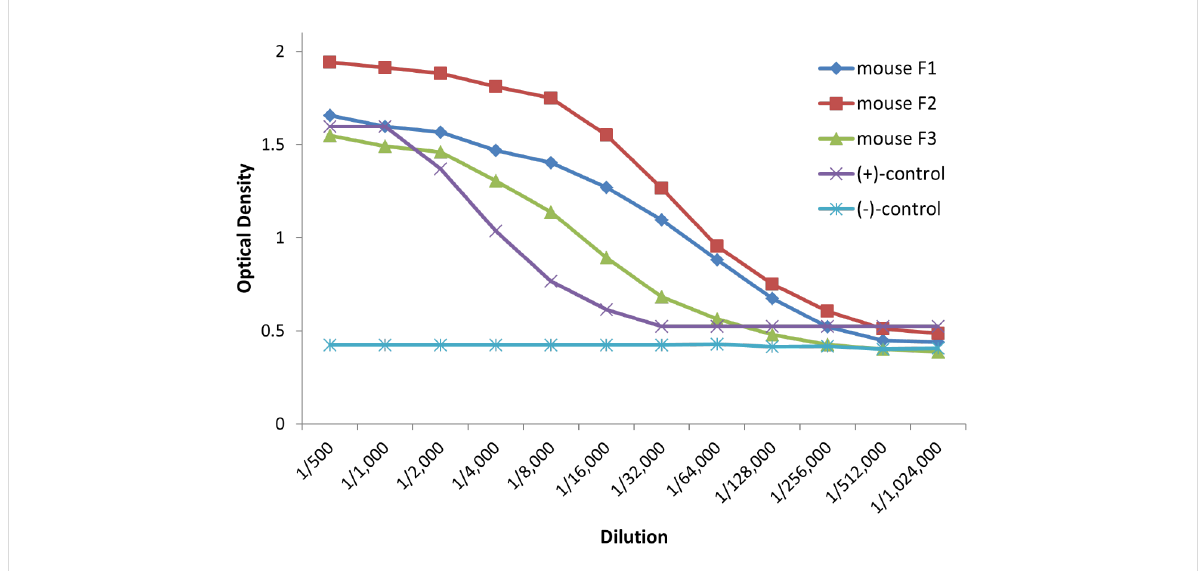
Figure 2: ELISA of the antiserum of mouse 2 induced by 4’F-TF-Thr 6 -MUC1(20)-TTox vaccine 18b ; coat: 5 µg/mL 4’F-TF-Thr 6 -MUC1(20)-BSA 18a (for more details cf. Supporting Information File 1). Animals’ experiments were performed in accordance with institutional guidelines approved by Johannes Gutenberg-Universität Mainz and Landesuntersuchungsamt Koblenz.